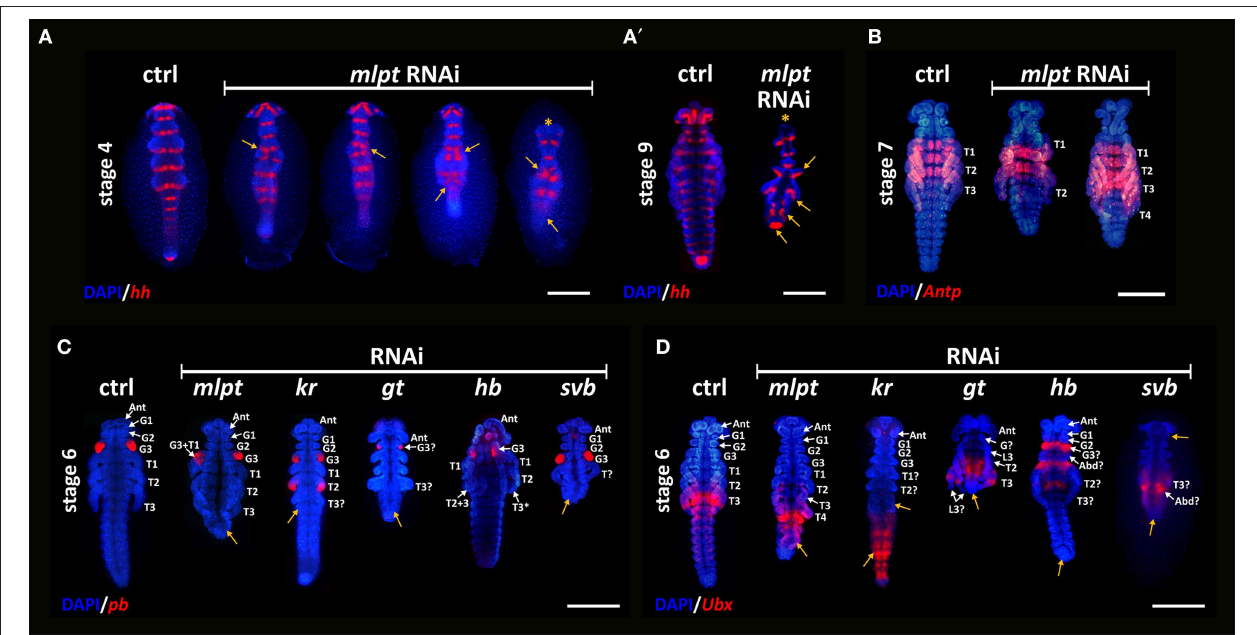
FIGURE 7 | Segmental fusion and Hox gene expression in knockdown embryos of mlpt and other developmental genes. (A) In situ hybridization for hedgehog ( hh ) and nuclear counterstaining with DAPI of control (ctrl) in the left and progressive stronger mlpt dsRNA phenotypes from left to right. Yellow arrows highlight apparent segmental fusions at the thoracic regions. In the strongest phenotype (right most) the head is affected (asterisk) and germ band elongation did not occur. (A ′ ) At stage 9 one control (ctrl) one strongly affected mlpt dsRNA embryo, showing segmentation and head defects. (B) ANTP antibody staining in control and Rp-mlpt RNAi embryos. ANTP antibody marks the first and the second legs (L1 and L2) and the three thoracic segments in control embryos. Middle row— Rp-mlpt embryos show two fused segments (L1 and L2) and a third leg (L3), which does not express ANTP. Rightmost embryo shows four legs with a probable duplication of L3, since the two most posterior legs do not express ANTP. (C) pb expression in control and RNAi embryos. In control embryos at stage 6, pb is expressed in the third gnathal segment, corresponding to the prospective labium. After mlpt RNAi pb is either non-affected (right side) or an irregular shape (left side). Duplications or lack of staining were not observed after mlpt RNAi. Kr RNAi embryos show duplication patterns, gt RNAi embryos show a smaller group of expressing cells and the lack of anterior gnathal segments. svb RNAi displays clear segmentation deviations from the wild-type pattern, but does not display changes in pb staining. (D) Ubx expression in control and RNAi embryos. Ubx expression is stronger at the first abdominal segment and in concentric rings of the third leg. After mlpt RNAi Ubx is still strongly expressed in the first abdominal segment and not in concentric rings of the third leg. Kr RNAi embryos show diffuse staining in the abdominal region. Strong phenotype of gt RNAi embryos lack abdominal Ubx expression, while this marker is expressed in two consecutive pairs of legs, suggesting duplication of the third leg (L3). Hb RNAi embryos display Ubx expression at anterior (gnathal) segments. No Ubx staining was observed in the legs. A strong svb RNAi embryo lacks the posterior abdominal but show expression of Ubx